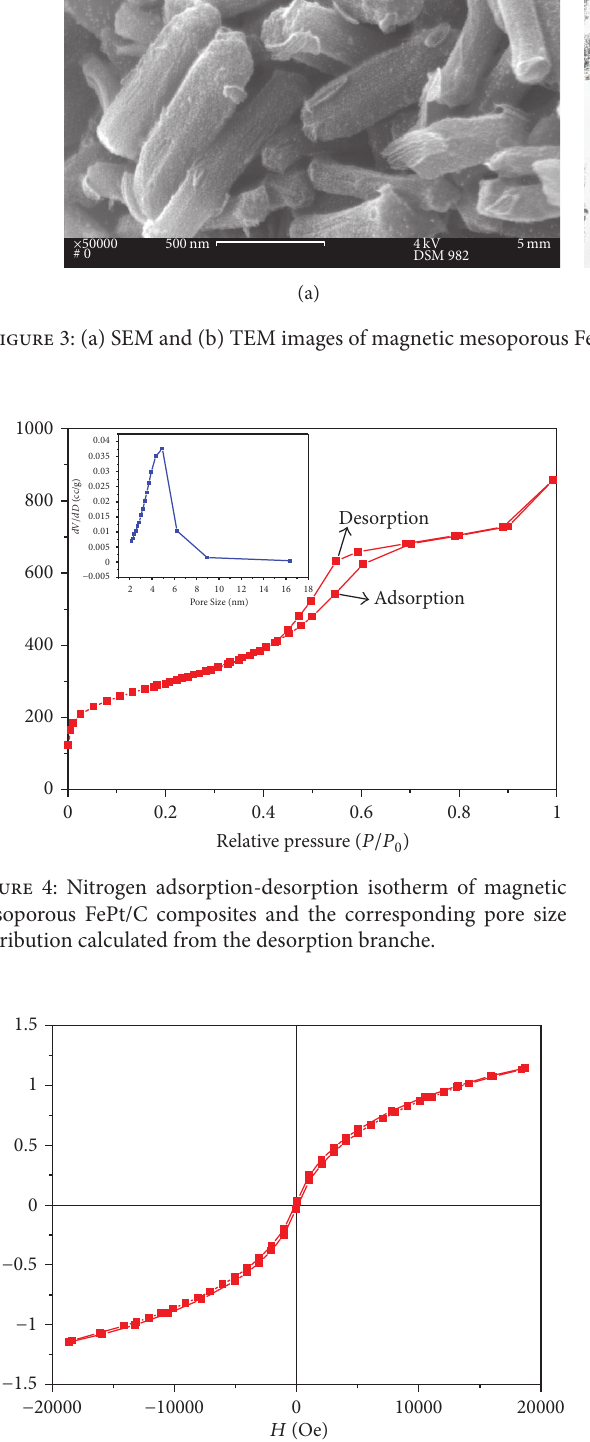
F 5: Magnetization curve of magnetic mesoporous FePt/C composites measured at room